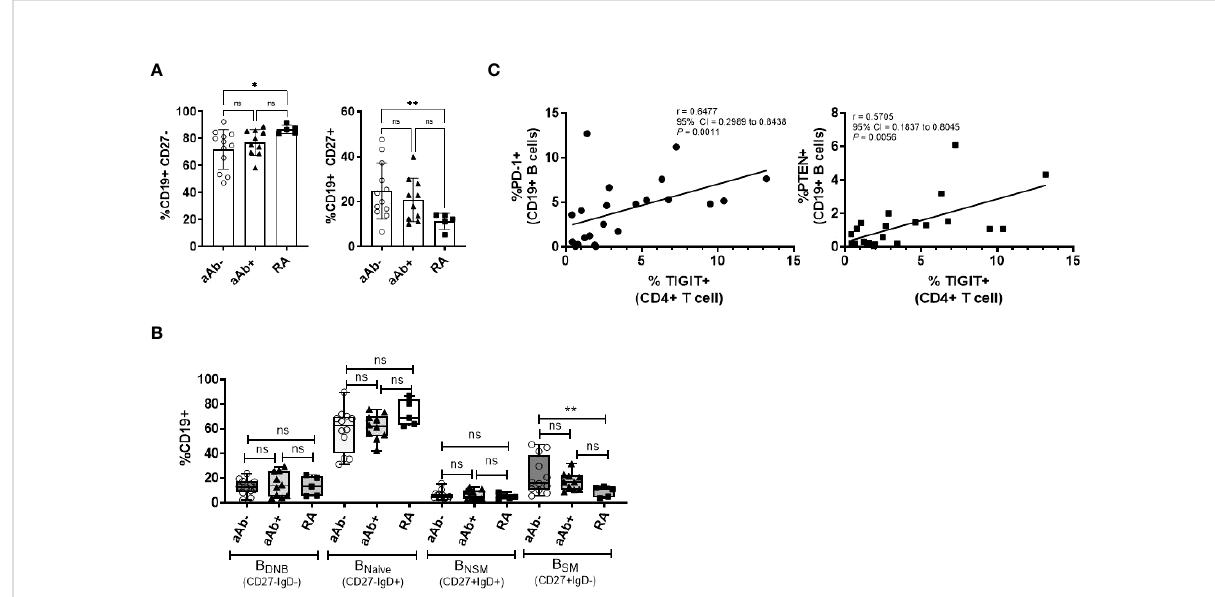
FIGURE 3 (A) Box-whiskers plot showing the frequency of CD19 + CD27 - (naïve) and CD19 + CD27 + (memory) B cells between aAb-FDR (n=12), aAb+FDR (n=10) and RA patients (n=5). (B) Box-whiskers plot showing the frequency of B-cell subsets between aAb-FDR, aAb+FDR and RA patients. (C) Spearman correlation plots showing the relationship between the frequency of TIGIT+ CD T cells (x-axis) and frequency of PD-1 + or PTEN + (y-axis) in FDR (n=34). Data was analyzed by Kruskal-Wallis test with Dunn ’ s post-hoc analysis. *P<0.05, **P<0.01, ns, non-signi fi